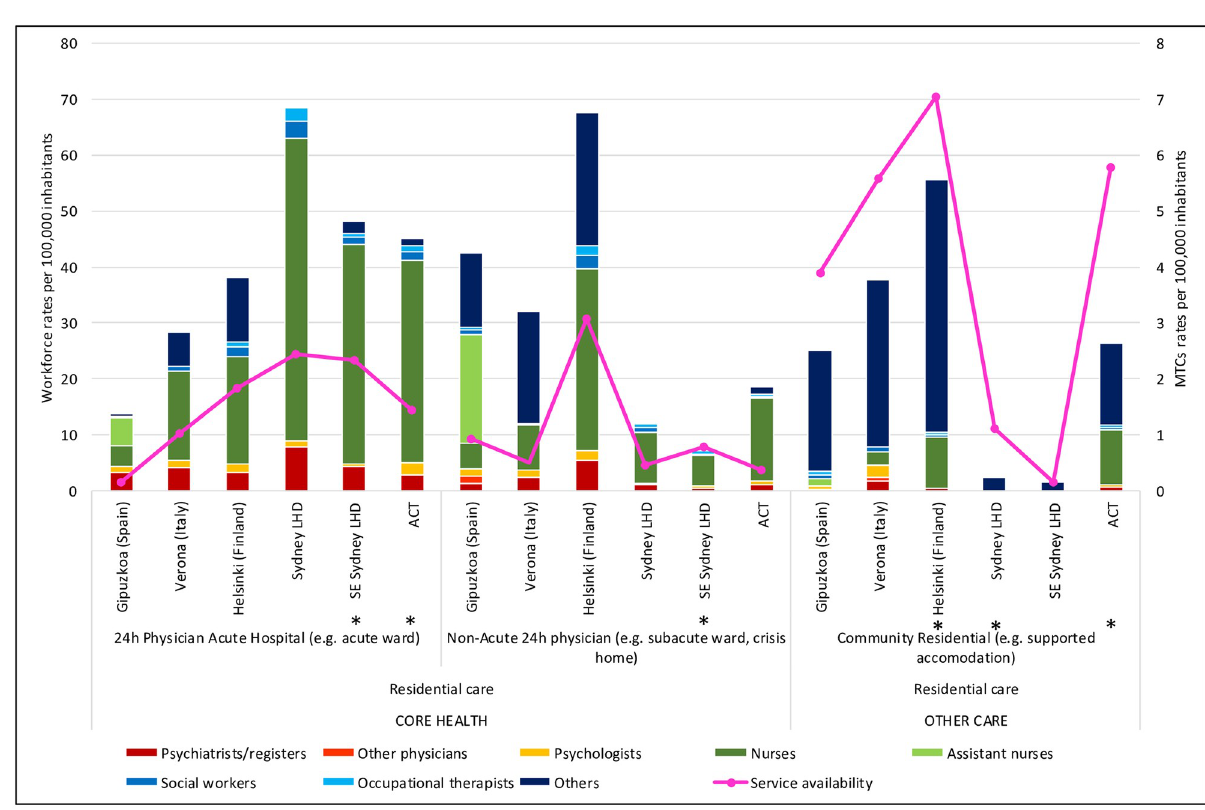
Fig 1. Workforce rates and availability in adult mental health services for residential care in the six study areas. � Missing data.